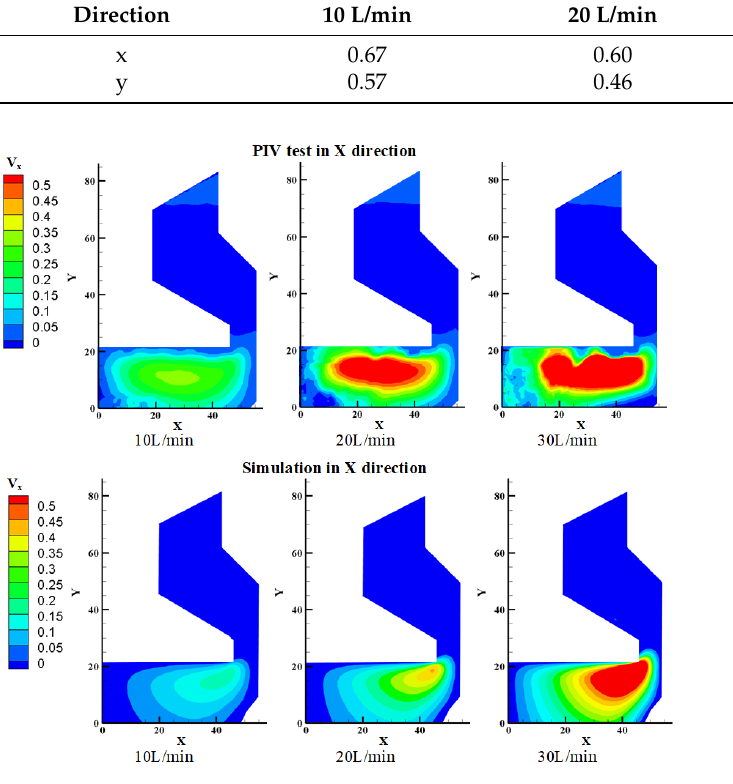
Figure 4. Comparison of PIV test results with simulation results in X direction.